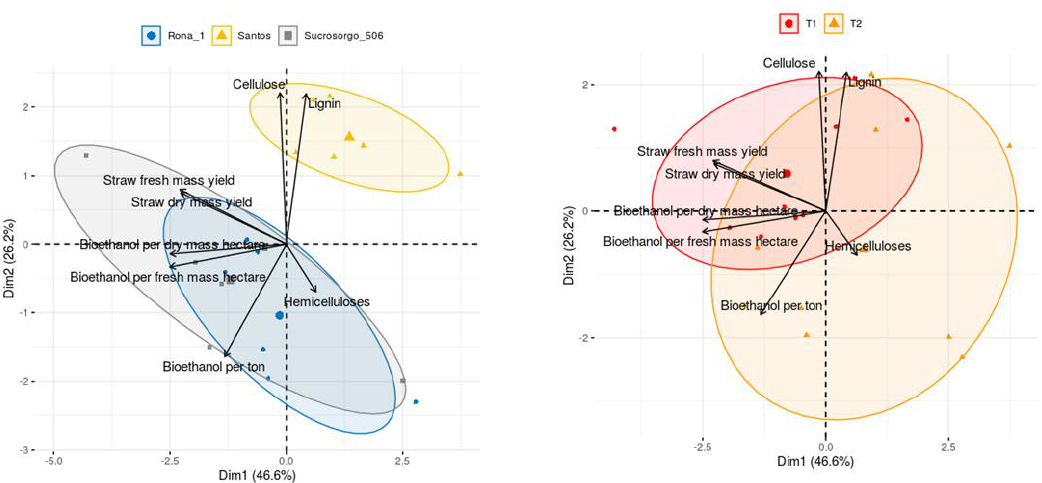
Figure 2. Principal component analysis of tested sorghum cultivars, cases grouped by the cultivars and term. Ellipsoids indicate 67% confidence. (T1—main crop; T2—second crop).